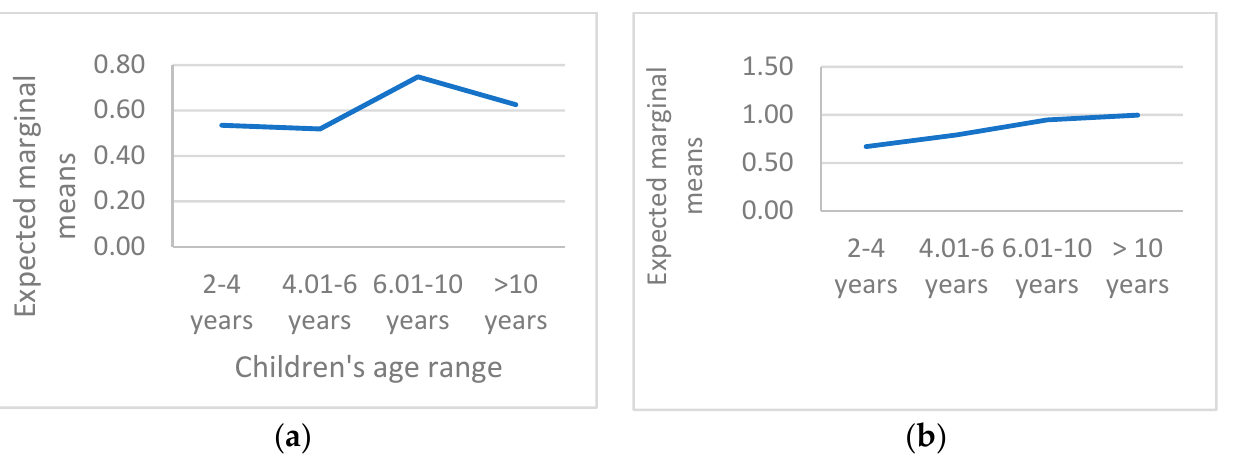
Figure 1. ( a ): Use of distraction along children’s age ranges. ( b ): Use of cognitive self-instruction along children’s age ranges.